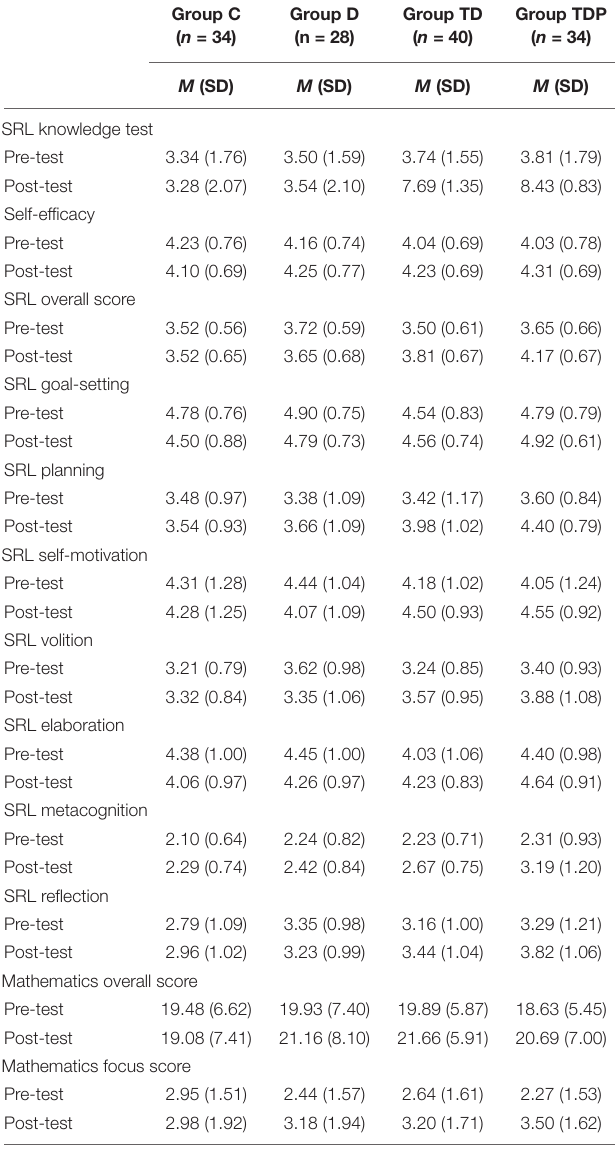
TABLE 1 | Mean and standard deviation for each experimental group for self-regulated learning (SRL) knowledge, self-efficacy, overall SRL score, SRL subscales, mathematics overall score, and mathematics focus score on pre- and